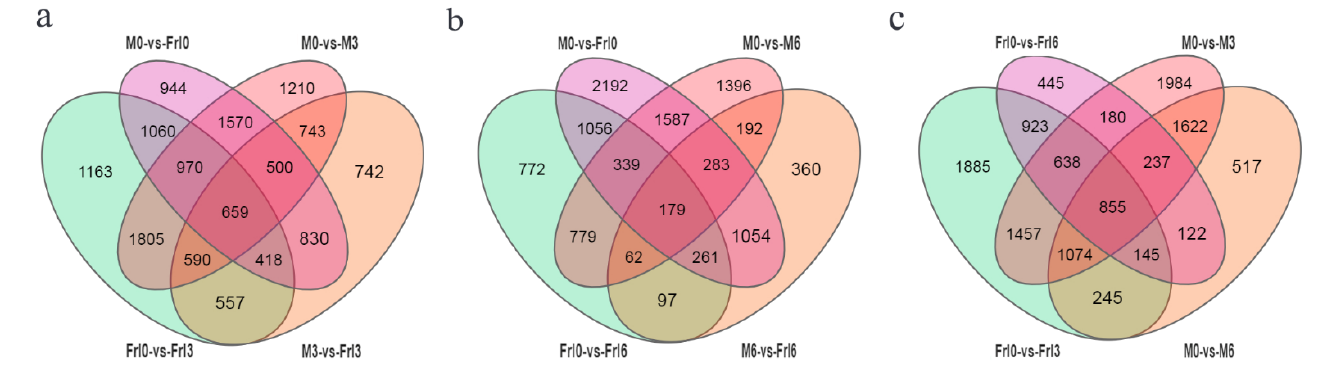
Figure 3. Venn diagrams presenting DEGs in diverse comparisons after FORL inoculation. ( a ) Venn chart of DEGs identified in the M0 vs. Frl0, M0 vs. M3, Frl0 vs. Frl3, and M3 vs. Frl3 comparisons. ( b ) Venn diagram of DEGs identified in the M0 vs. Frl0, M0 vs. M6, Frl0 vs. Frl6, and M6 vs. Frl6 comparisons. ( c ) Venn diagram of DEGs identified in the Frl0 vs. Frl6, M0 vs. M3, Frl0 vs. Frl3, and M0 vs. M6 comparisons.